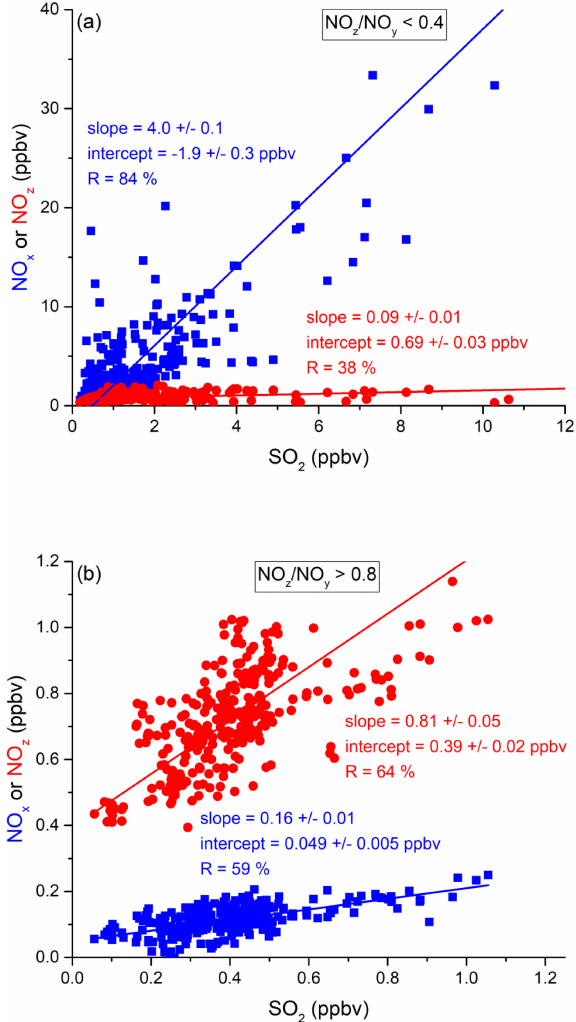
Figure 5. Correlation between SO 2 and NO x or NO z for (a) fresh and (b) aged NO x emissions in the Mediterranean Sea